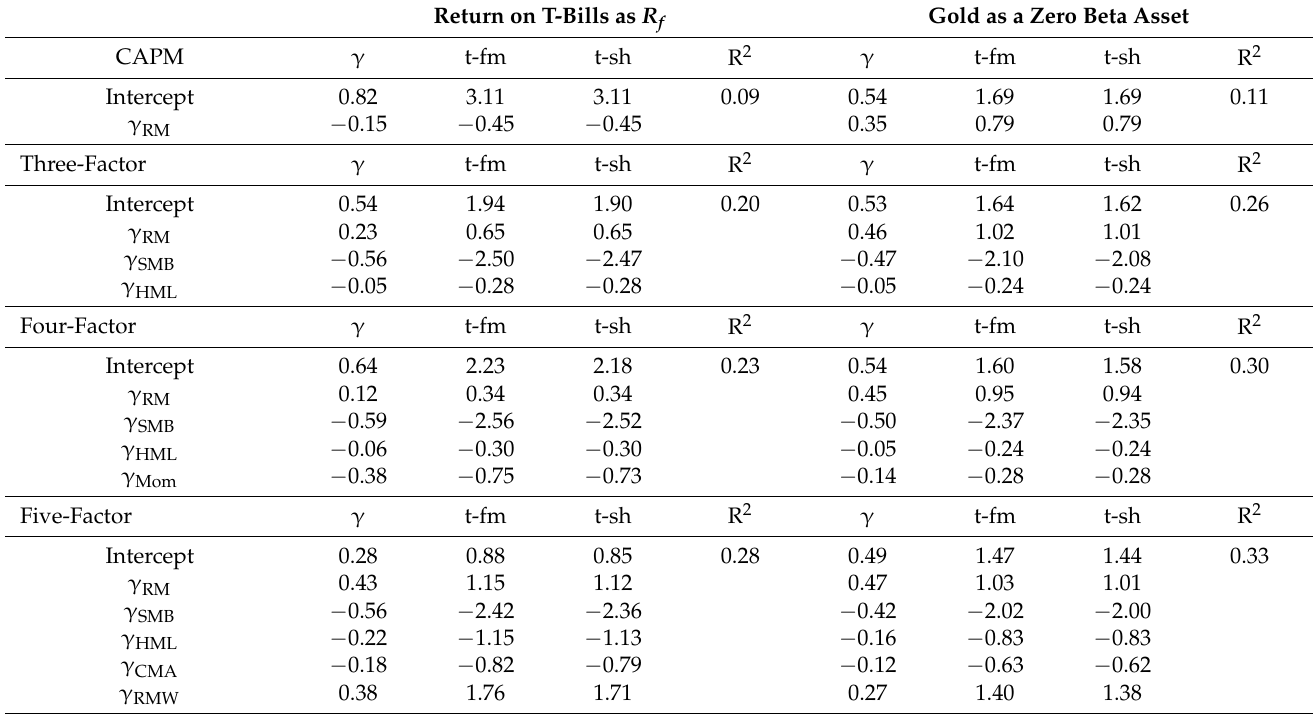
Table 7. Fama–MacBeth tests on 49 industry portfolios from January 1981 to December 2015. The table reports average coefficients for the CAPM, three-factor, four-factor, five-factor, and six-factor models. Results represent monthly percent returns. The first column reports results with Treasury bills as risk-free assets, whereas the second column reports gold as a zero-beta asset. γ is the average coefficient, t-sh is the t-statistic after correcting for errors-in-variables (Shanken 1992), and R 2 is the average cross-sectional R-squared of the tested models. Return on T-Bills as R f Gold as a Zero Beta Asset